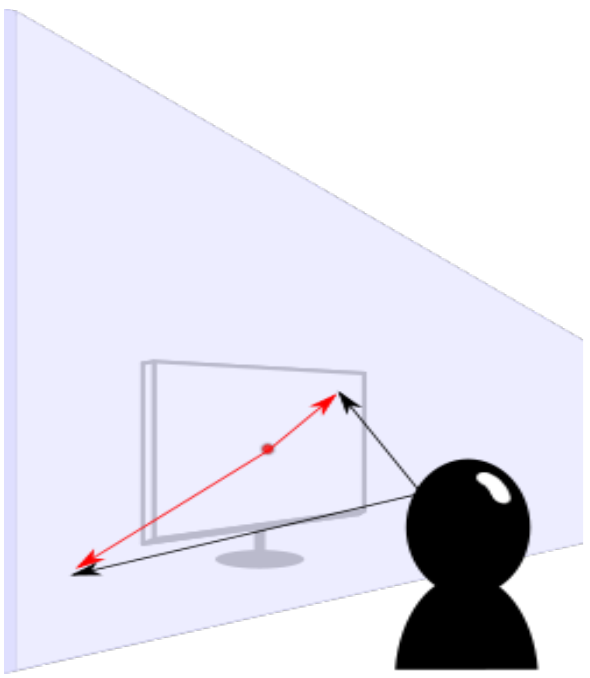
Figure 4. Vectors in black are the original 3-D coordinates generated by OpenFace, whereas the red vectors are the 2-D vectors resulting from the planar